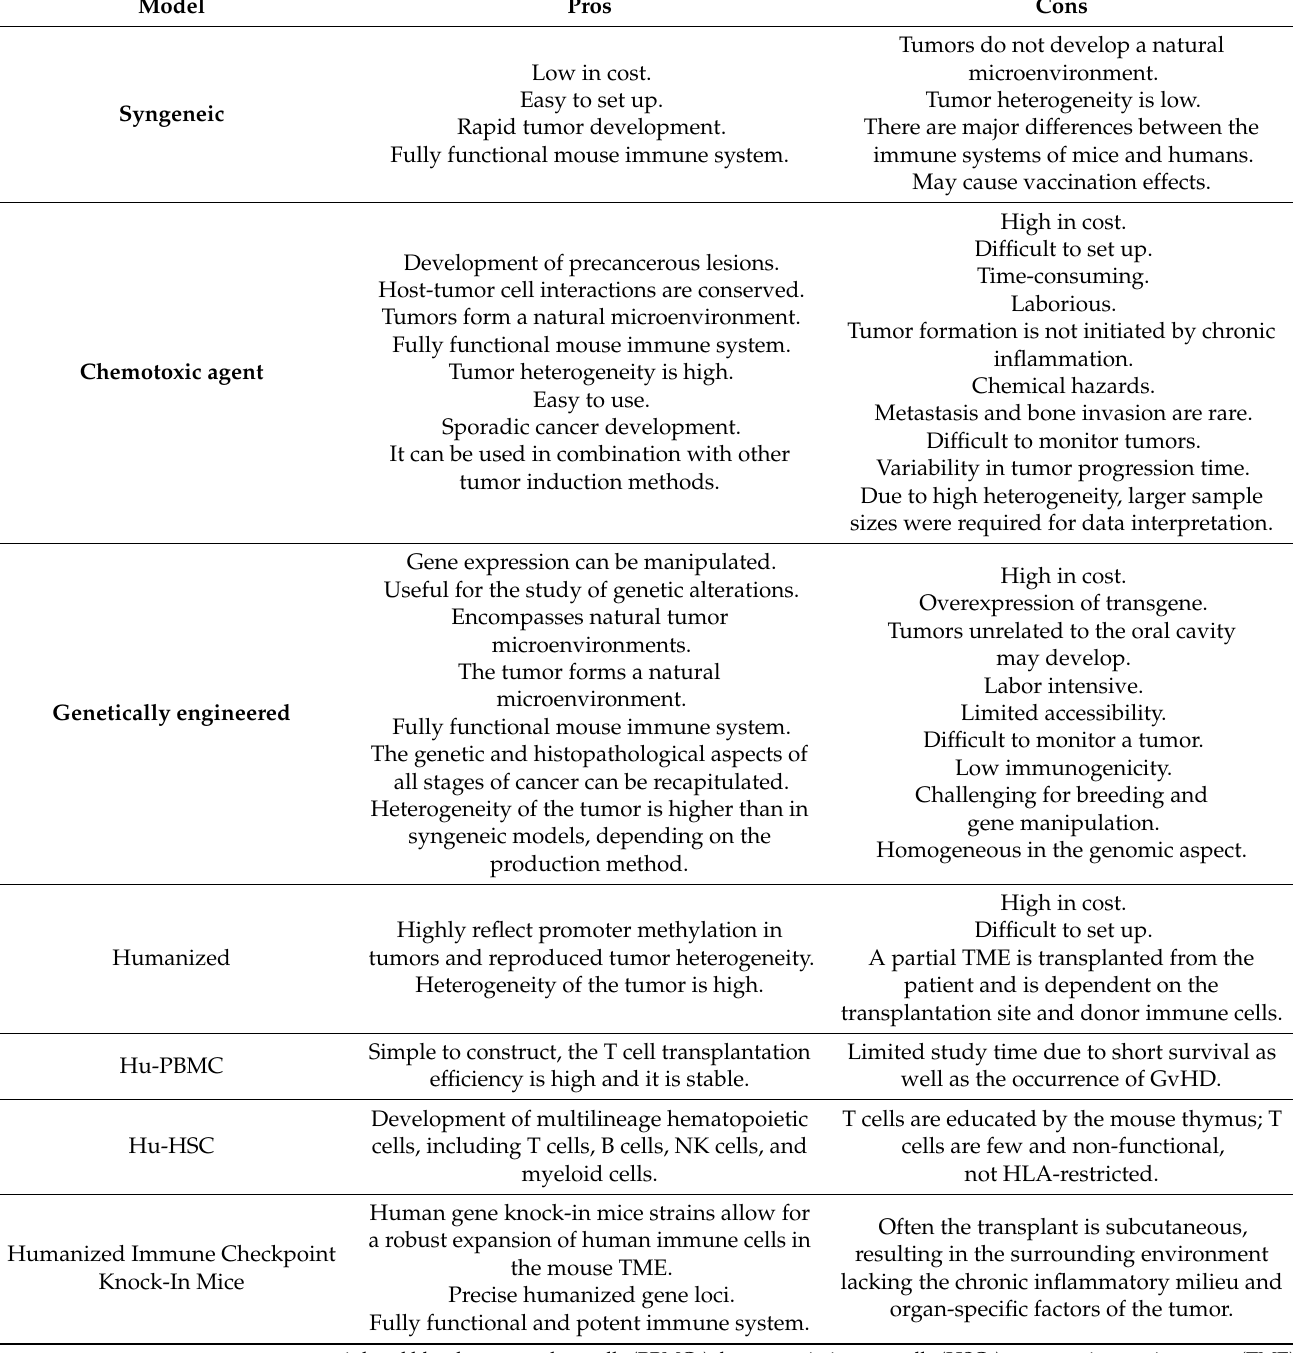
Table 2. The pros and cons of murine models for immunotherapy research in oral tumors.